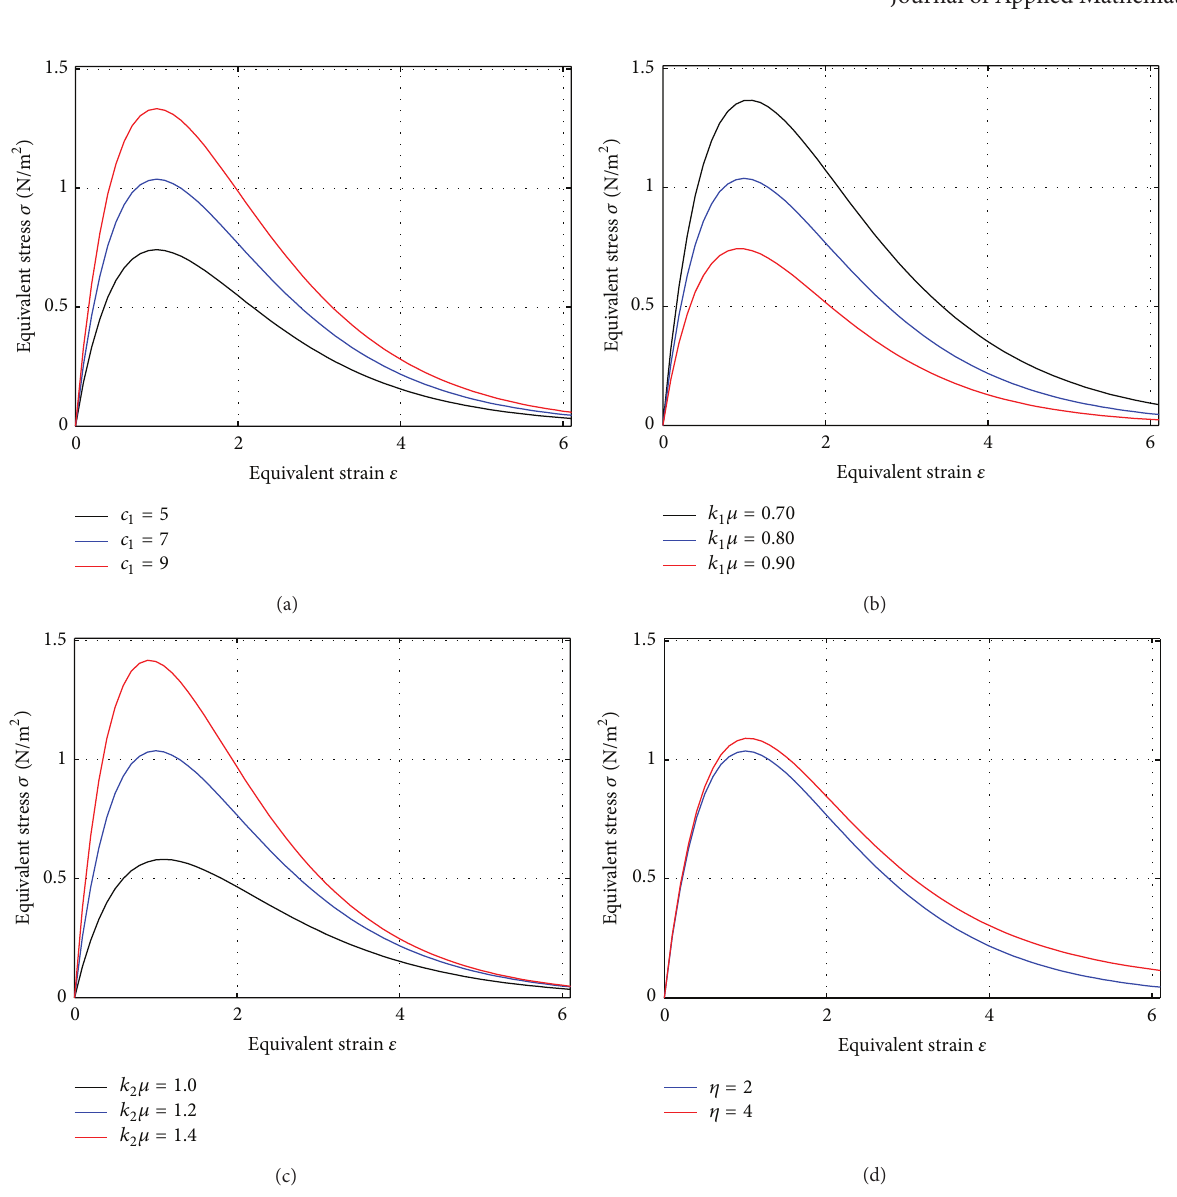
Figure 7: Approximate solutions based on SIR model with different